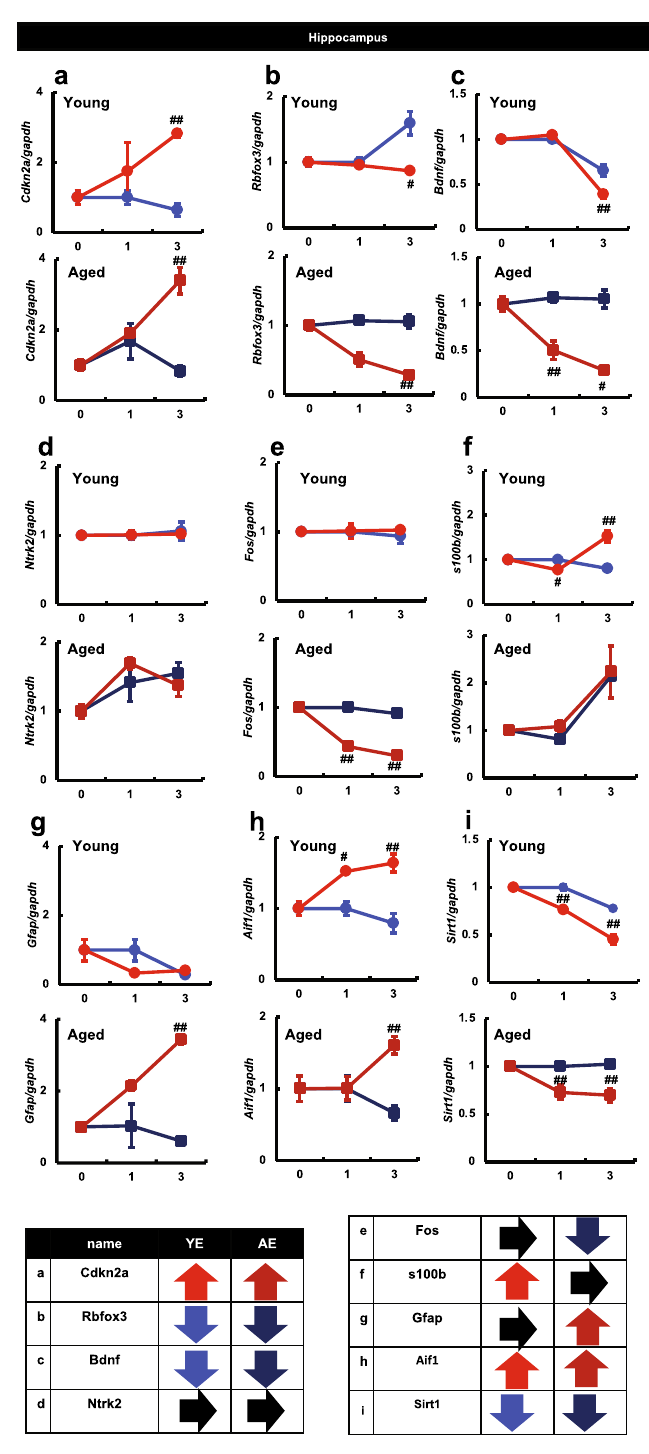
Figure 3. Effects of maxillary molar loss on gene expression in the hippocampus of mice (Real-time PCR). The vertical axis indicates the expression level. The horizontal axis indicates the month, with YC1 or AC1 as 1. ## P < 0.01; # P < 0.05 vs. control (Tukey’s post-hoc test). Results are presented as means ± SE. Target gene expression was normalized to that of the housekeeping gene, Gapdh , and the results are presented for each sample relative to the control. The expression levels of ( a ) Cdkn2a , ( b ) Rbfox3 , ( c ) Bdnf , ( d ) Ntrk2 , ( e ) Fos , ( f ) 100b , ( g ) Gfap , ( h ) Aif1 , ( i ) Sirt1 are shown. ( j ) Table indicating the relative changes in expression of each gene in the control and extraction groups are indicated with arrows (YC vs. YE and AC vs. AE). YC young control group, YE young extraction group, AC aged control group, AE aged extraction